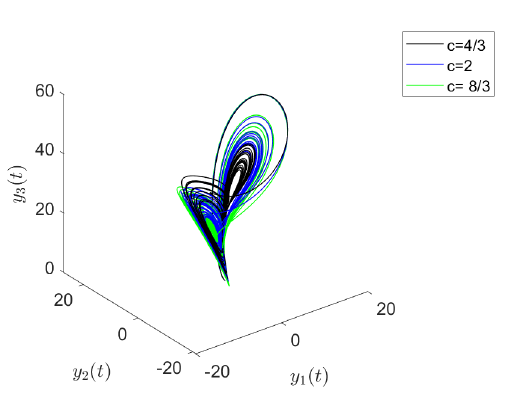
Figure 25. Phase portraits of y 1 , y 2 and y 3 when varying c .